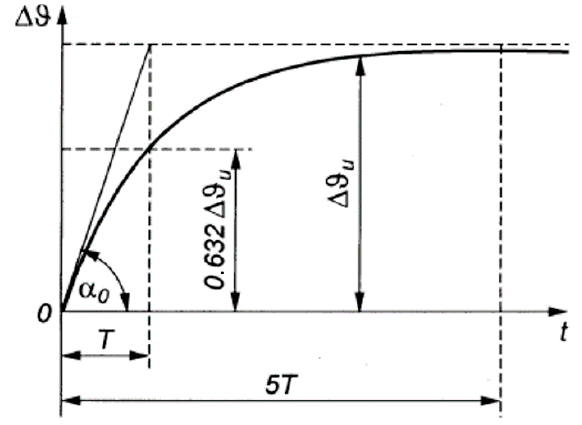
Figure 7. Typical characteristic of current circuit heating.